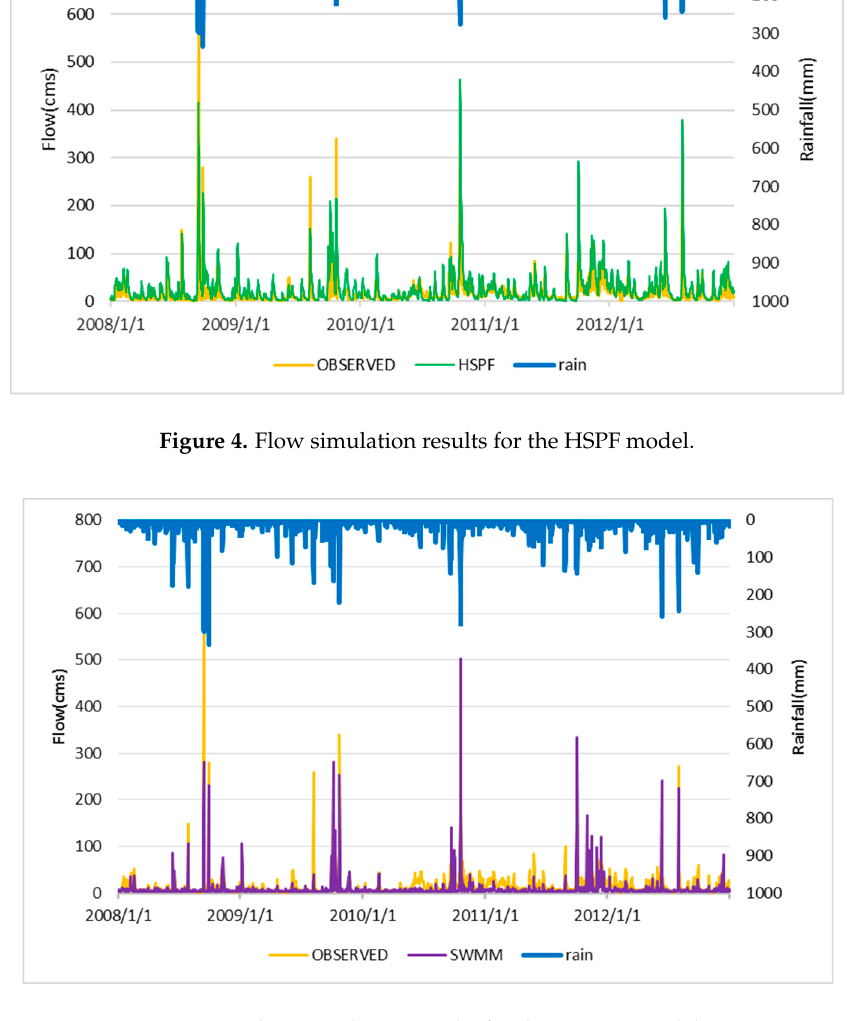
Table 4. Results of the model fitness analysis for daily flow.